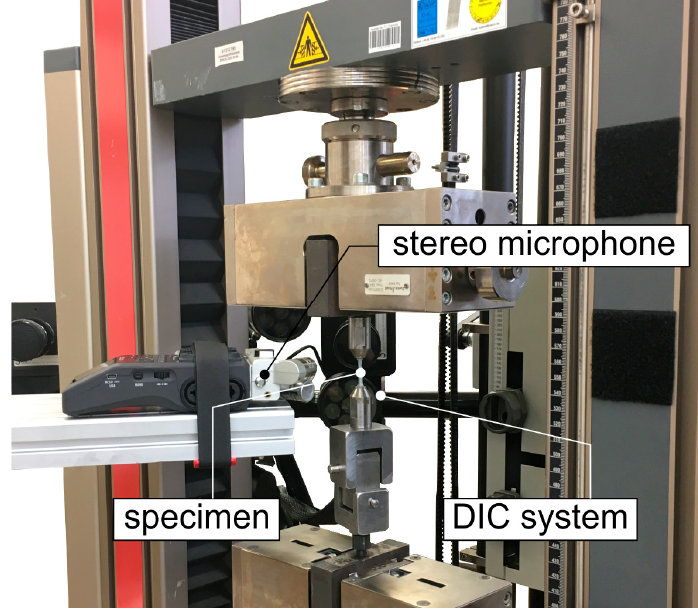
Figure 2. Experimental setup for digital image correlation (DIC) observations used during tensile testing. In addition to the optical measurement components, a highly sensitive unidirectional stereo microphone was used to measure the acoustic emission associated with The Portevin–Le Châtelier (PLC)